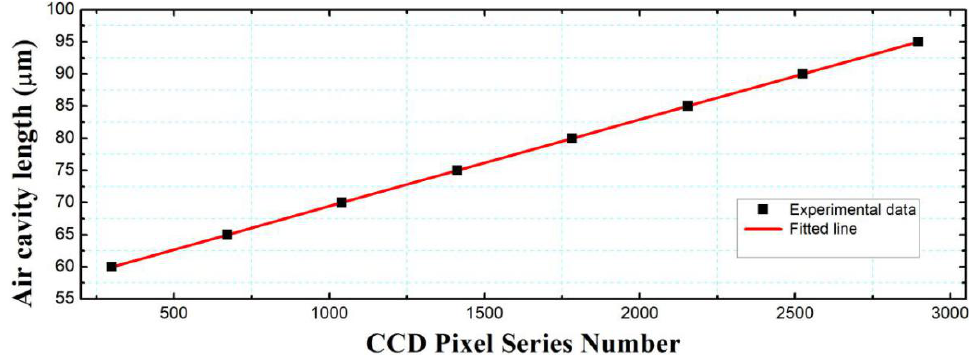
Figure 6. Calibration of the relationship between the wedge thickness and the CCD pixel serial